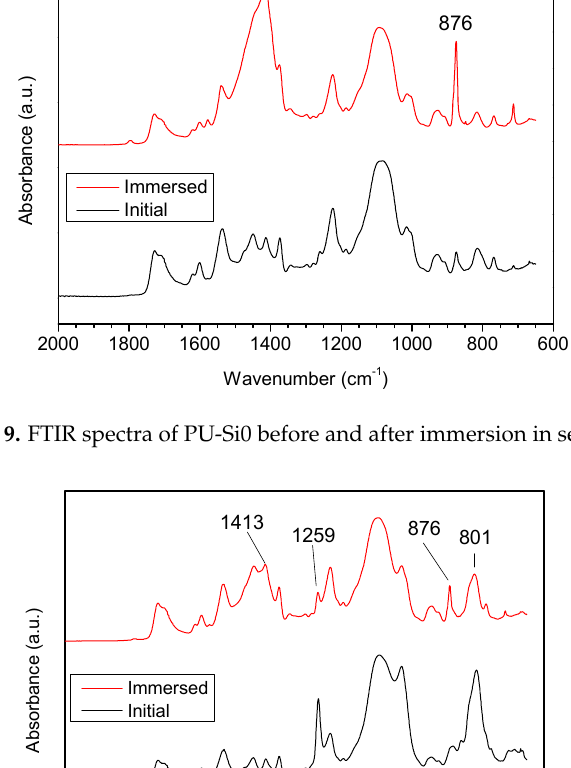
Figure 11. Infrared absorptivity reduction at 800 and 1260 cm − 1 of samples containing PDMS after immersion in seawater. 3.2.2. Atomic Force Microscopy (AFM) Analysis Figure 12 shows AFM height and phase maps in the field of 500 nm × 500 nm of PU-Si0 and PU- Si17 after immersion in seawater. The texture of the height and phase maps of PU-Si0 after immersion was not regular. This was attributed to seawater influencing H-bonding interactions and phase